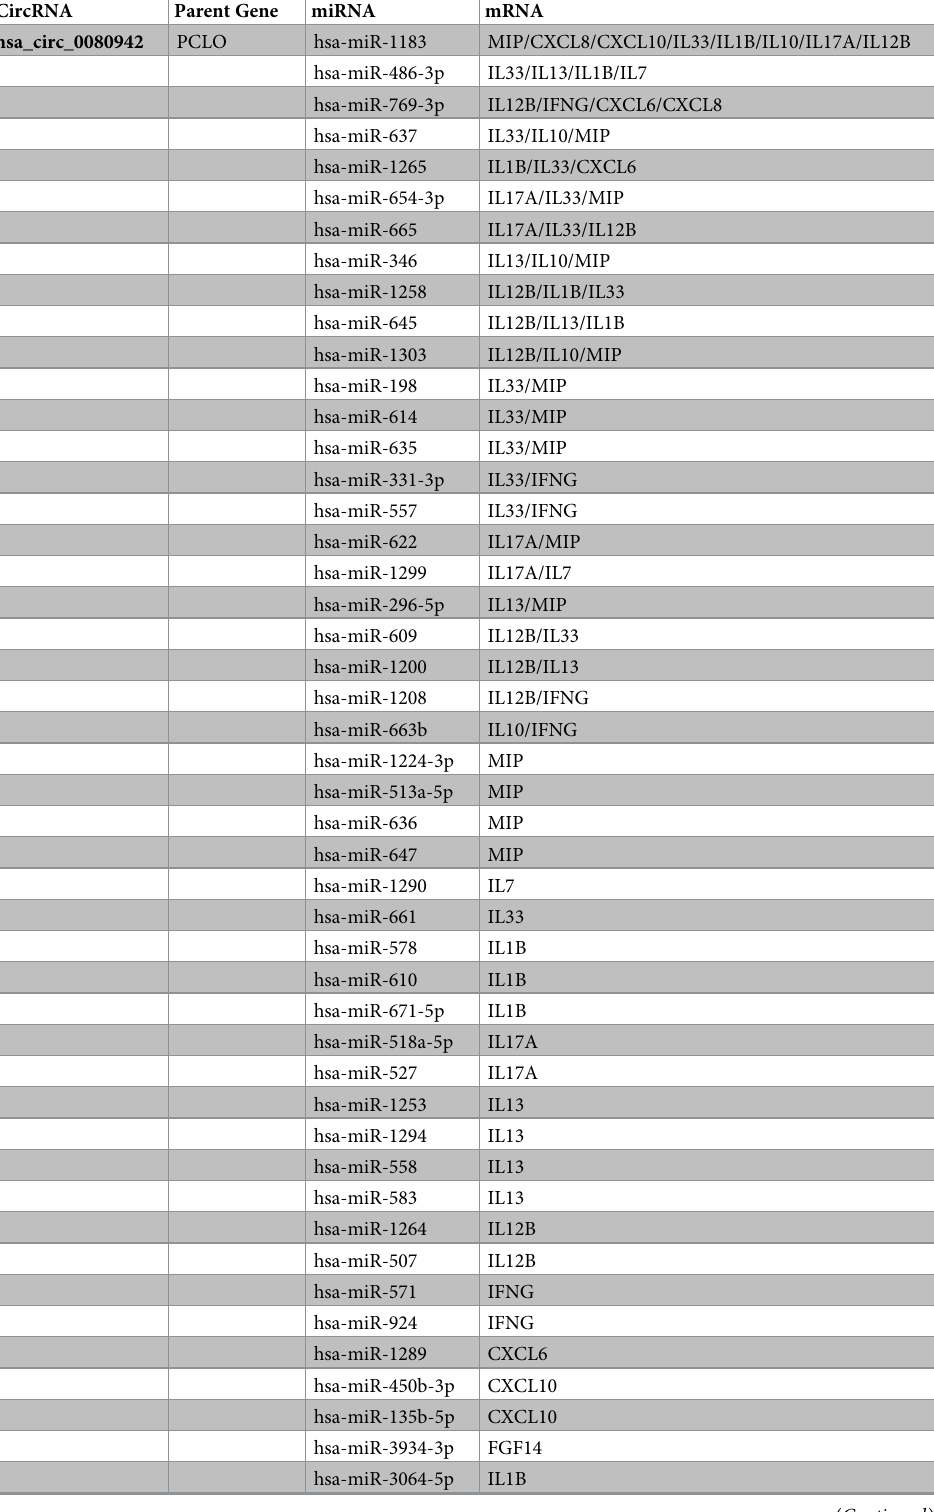
Table 5. SARS-CoV-2 induced cytokine storm related circRNA-miRNA-mRNA regulatory